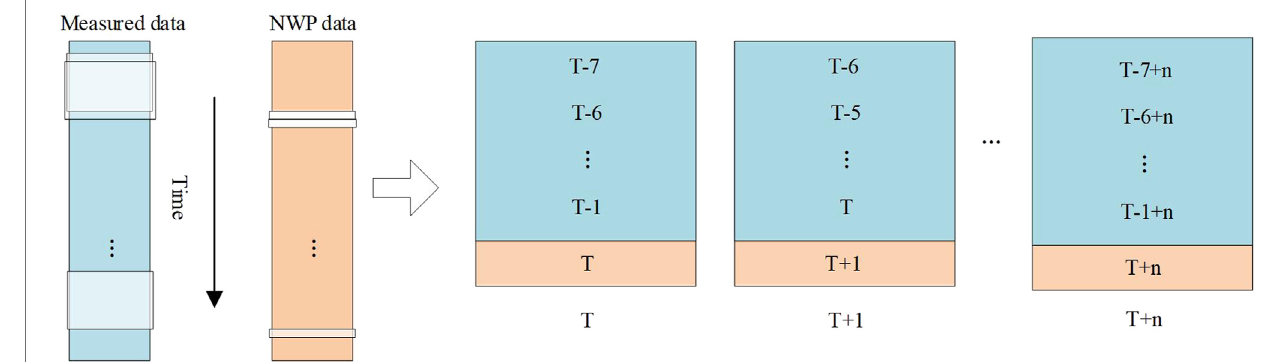
FIGURE 2 | The process of model input